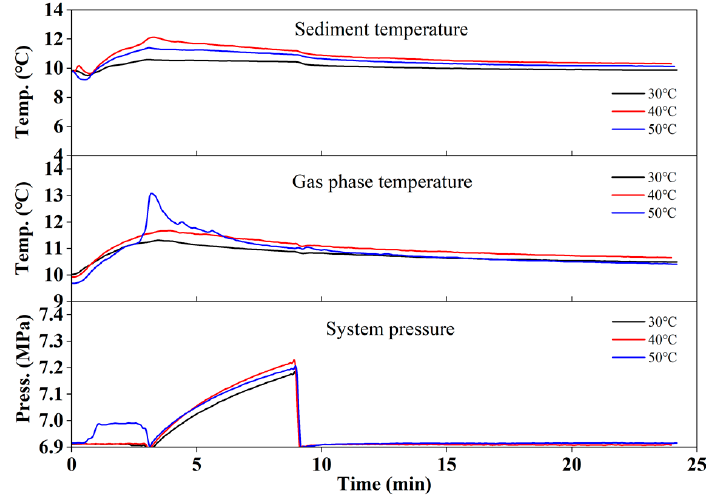
Figure 9. E ff ect of injection temperature of BIMICl solution on gas production. Figure 9. Effect of injection temperature of BIMICl solution on gas production.